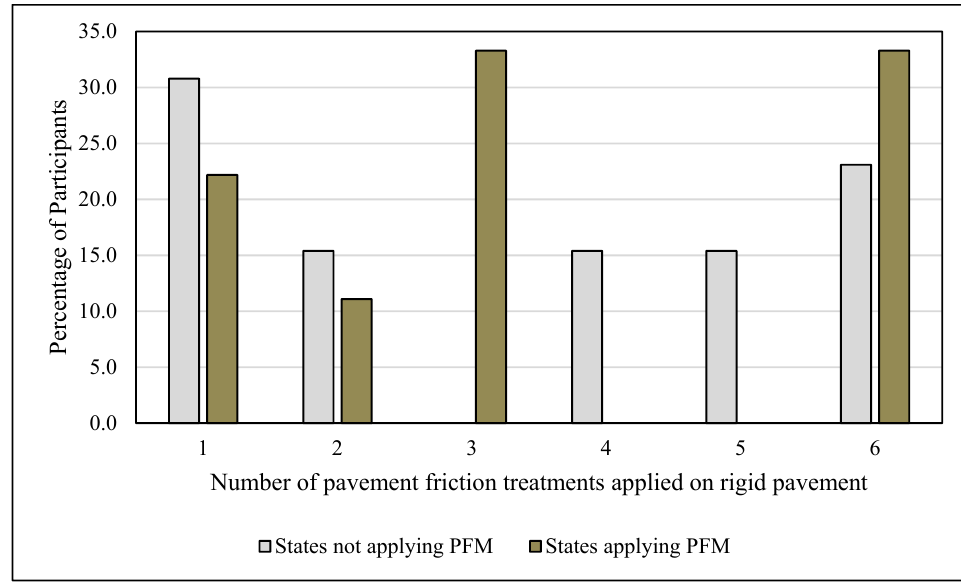
Figure 12. State DOT practices of pavement friction treatments on rigid pavement.